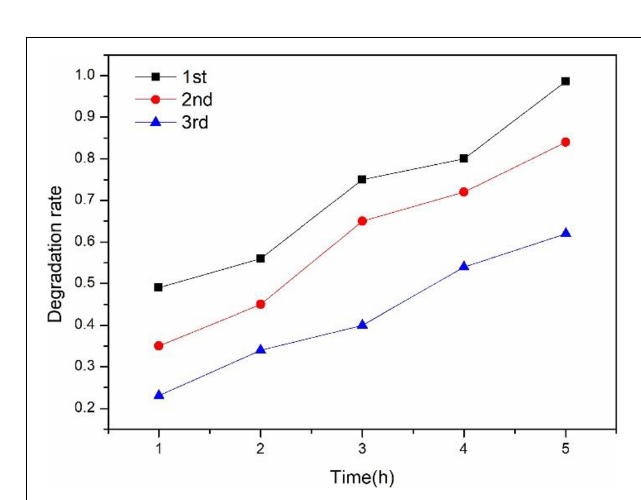
FIGURE 9 | Cycling degradation rate of